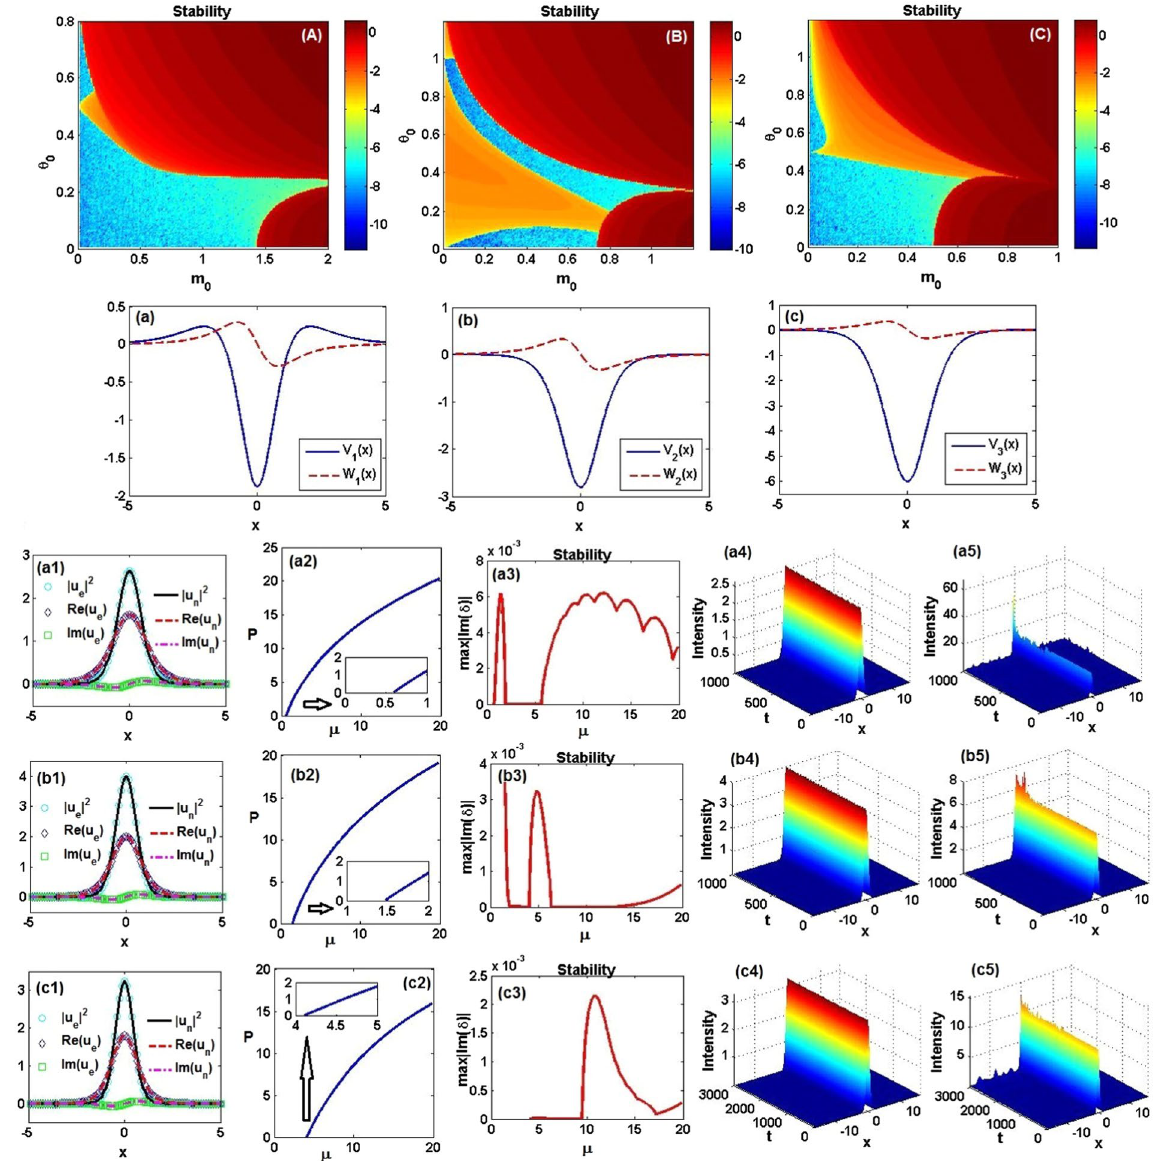
Figure 2. Stability of exact nonlinear modes (6). ( A – C ) The linear-stability map, as obtained from the numerical solution of Eq. (23), in the θ m ( , ) plane for α = 1, 2, 3 , respectively. The stability is determined by 0 0 the largest absolute value of imaginary parts of the linearization eigenvalue δ , which are displayed by means of the color bar on a common logarithmic scale, log[|(Im( δ )|)]. ( a – c ) The real and imaginary parts of the PT -symmetric complex potentials determined by Eqs. (3) and (4) for ( α , m 0 , θ 0 ) = (1, 0.5, 0.1), (2, 0.4, 0.1), (3, 0.2, 0.1), respectively. For α = 1, 2, 3, which correspond to ( a1 , b1 , c1 ), respectively, the real parts, imaginary parts, and intensity profiles are displayed, as obtained from the exact solutions, φ , and their numerically found e , for μ = 9/4, 4, 25/4, respectively. ( a2 , b2 , c2 ) Power P versus the counterparts (fundamental solitons), φ n frequency, − μ . ( a3 , b3 , c3 ) Linear-stability spectra of numerically found fundamental solitons versus μ . ( a4 , b4 , c4 ) The stable evolution of the solitons (no matter exact or numerical ones, the evolution being identical) from ( a1 , b1 , c1 ). ( a5 , b5 , c5 ) Unstable evolution of the numerically found solitons at µ µ µ = = = . 10, 5, 10 5 , respectively. The insets in ( a2 , b2 , c2 ) indicate power curves near the lower cutoff points of μ . Note that t-axes should be z-axes in ( a4 , a5 , b4 , b5 , c4 , c5